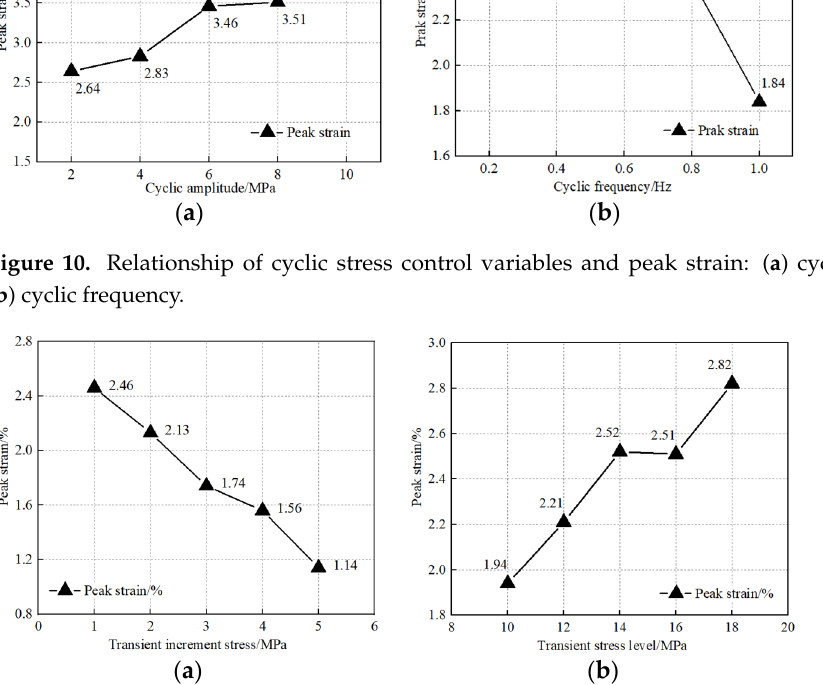
Figure 11. Relationship of transient stress control variables and peak strain: ( a ) transient increment; ( b ) stress level .